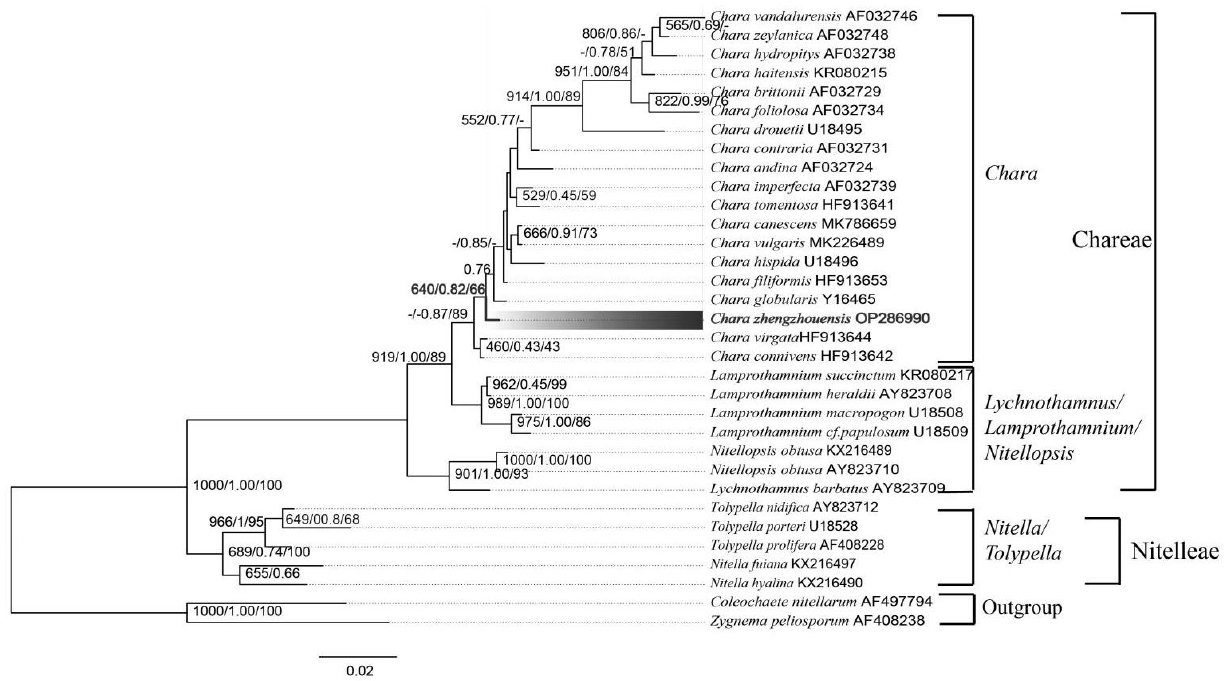
Figure 4. The phylogenetic tree constructed from 18S rDNA sequences. The numbers on the branch nodes represent the maximum likelihood bootstrap tree support values, Bayesian posterior probabilities, and neighbor joining bootstrap tree support values. Supporting values below 50% were noted with “ - ”.